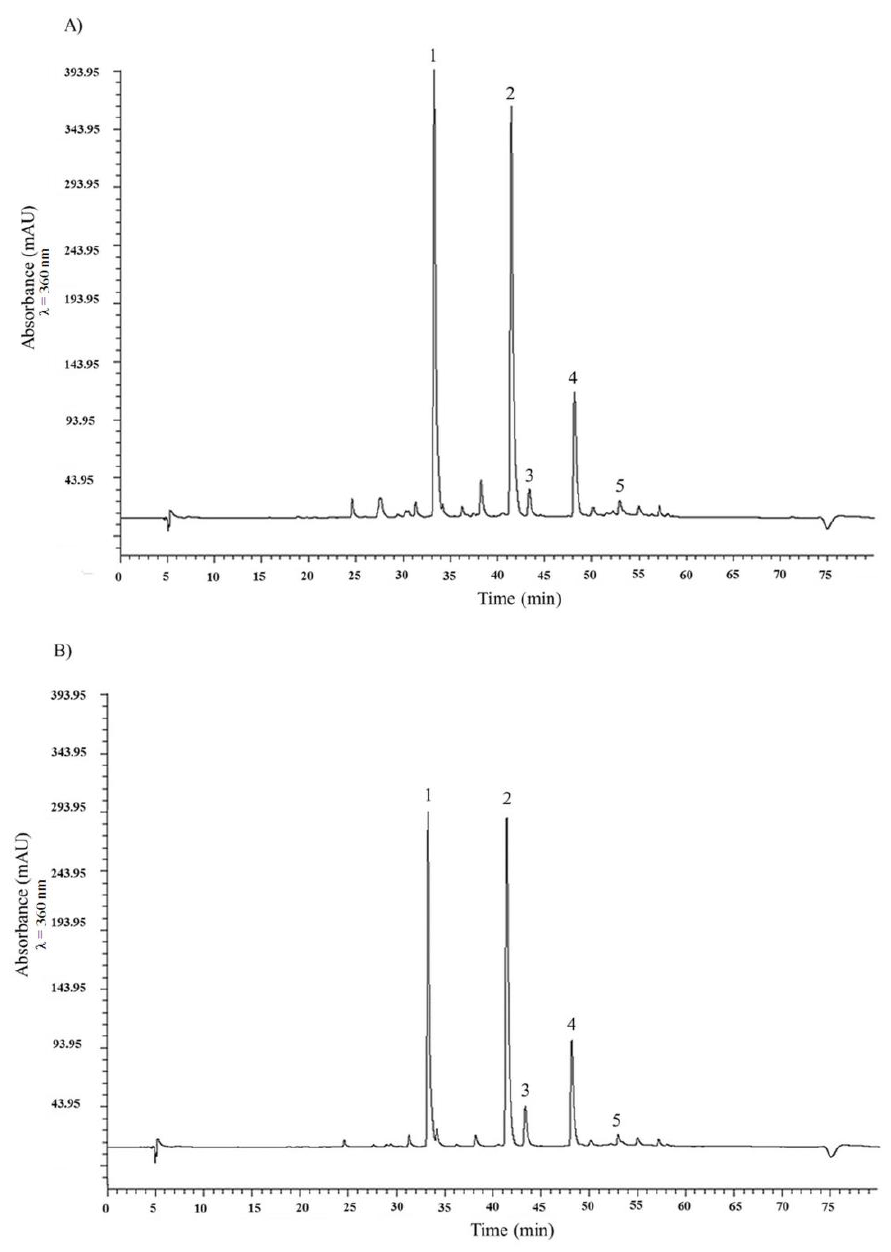
Figure 1. High-performance liquid chromatography (HPLC) chromatograms of A. × cornutum ( A ) and A. cepa ( B ) methanolic extracts at 360 nm. Depicted are peaks: ( 1 ) quercetin 3,4′-diglucoside; ( 2 ) quercetin 4′-monoglucoside; ( 3 ) quercetin; ( 4 ) ishorhamnetin; and ( 5 ) kaempferol.